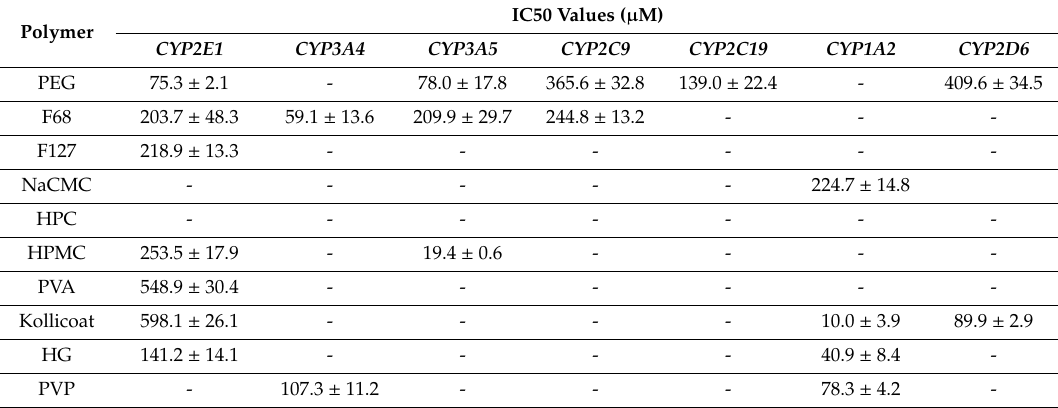
Table 4. E ff ect of di ff erent polymers on activities of CYP 2E1, 3A5, 2C9, 2C19, 1A2 and